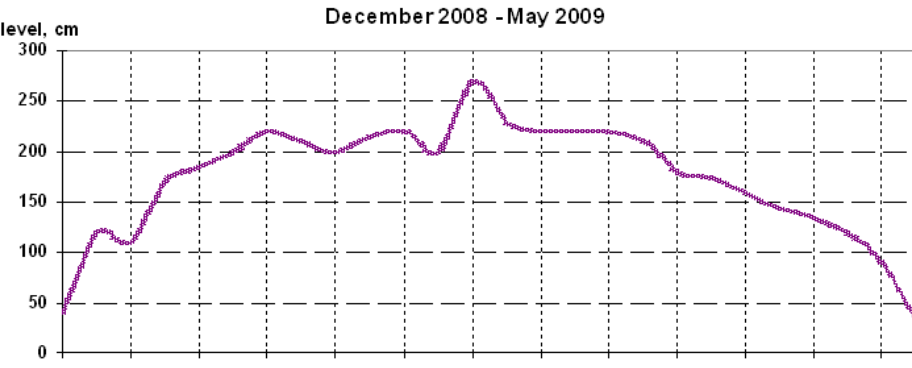
Figure 4. Snow level in winter